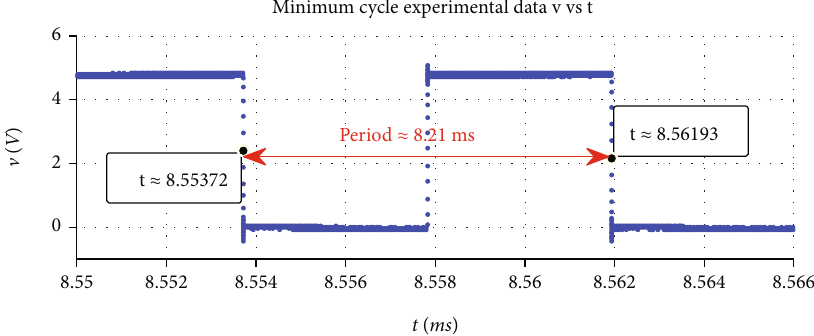
vs input solar irradiance G pv Sun